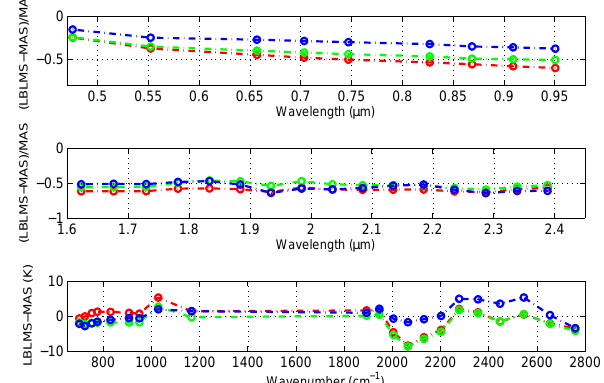
Fig. 13. Same as Fig. 12 but for the NIR spectral range.